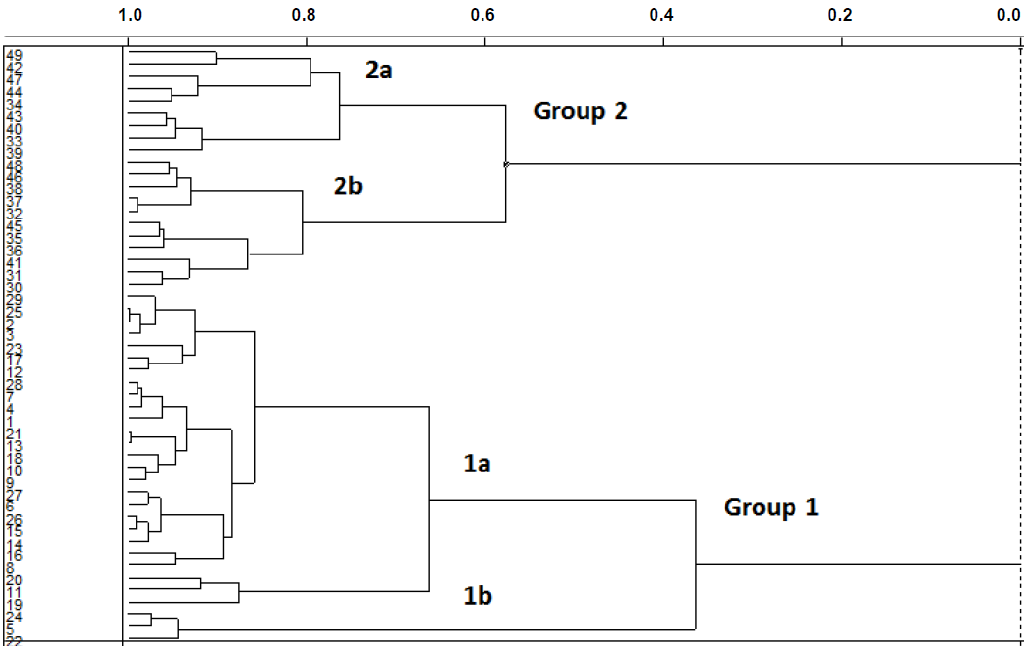
Figure 2. Dendrogram for the training set compounds obtained with incremental